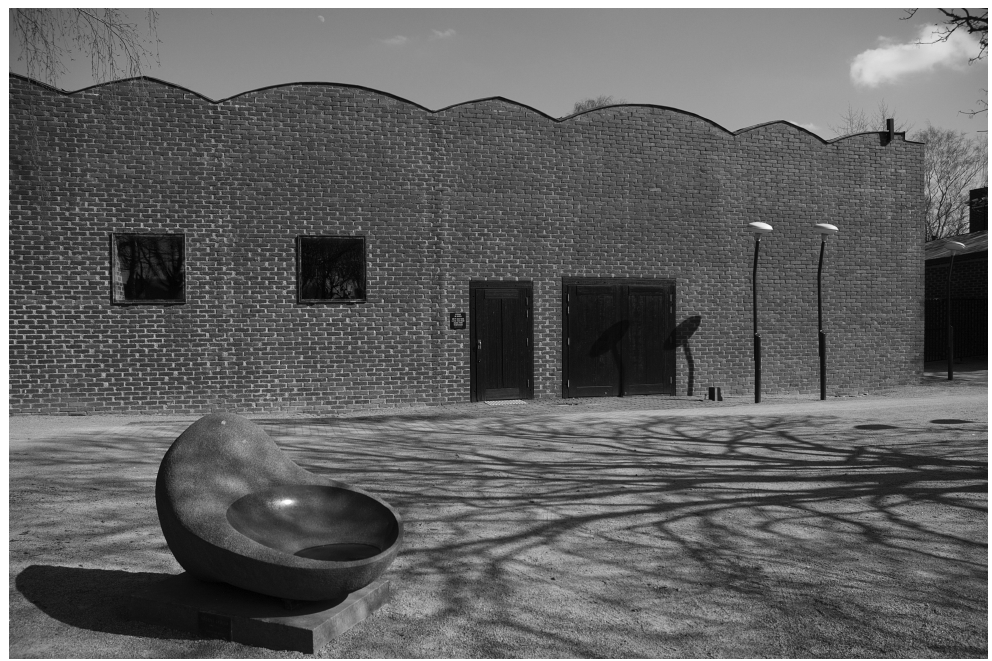
Figure 1: Sigurd Lewerentz, Church of Sankt Petri, west